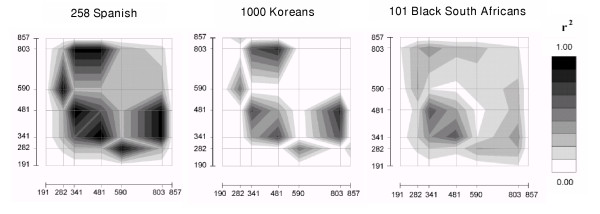
Linkage disequilibrium (r2 value) between SNP markers in the NAT2 locus. Graphical representation of the disequilibrium matrices obtained through computation of the r2 coefficient between each pair of markers, for the Spanish, Korean and Black South African samples. The British and Nicaraguan samples provided patterns and levels of LD comparable to those of the Spanish data. For each marker pair, GOLD [60] plotted the color-coded pairwise r2 statistics at the Cartesian coordinates corresponding to marker location, and the plots were completed by interpolation. These graphs point out the strong level of LD between markers at positions 341, 481, and 803, as well as between SNPs located at 282 and 590: these markers are thus strongly predictive of one another. In Black South Africans, LD patterns are less pronounced and more diffuse across marker pairs.